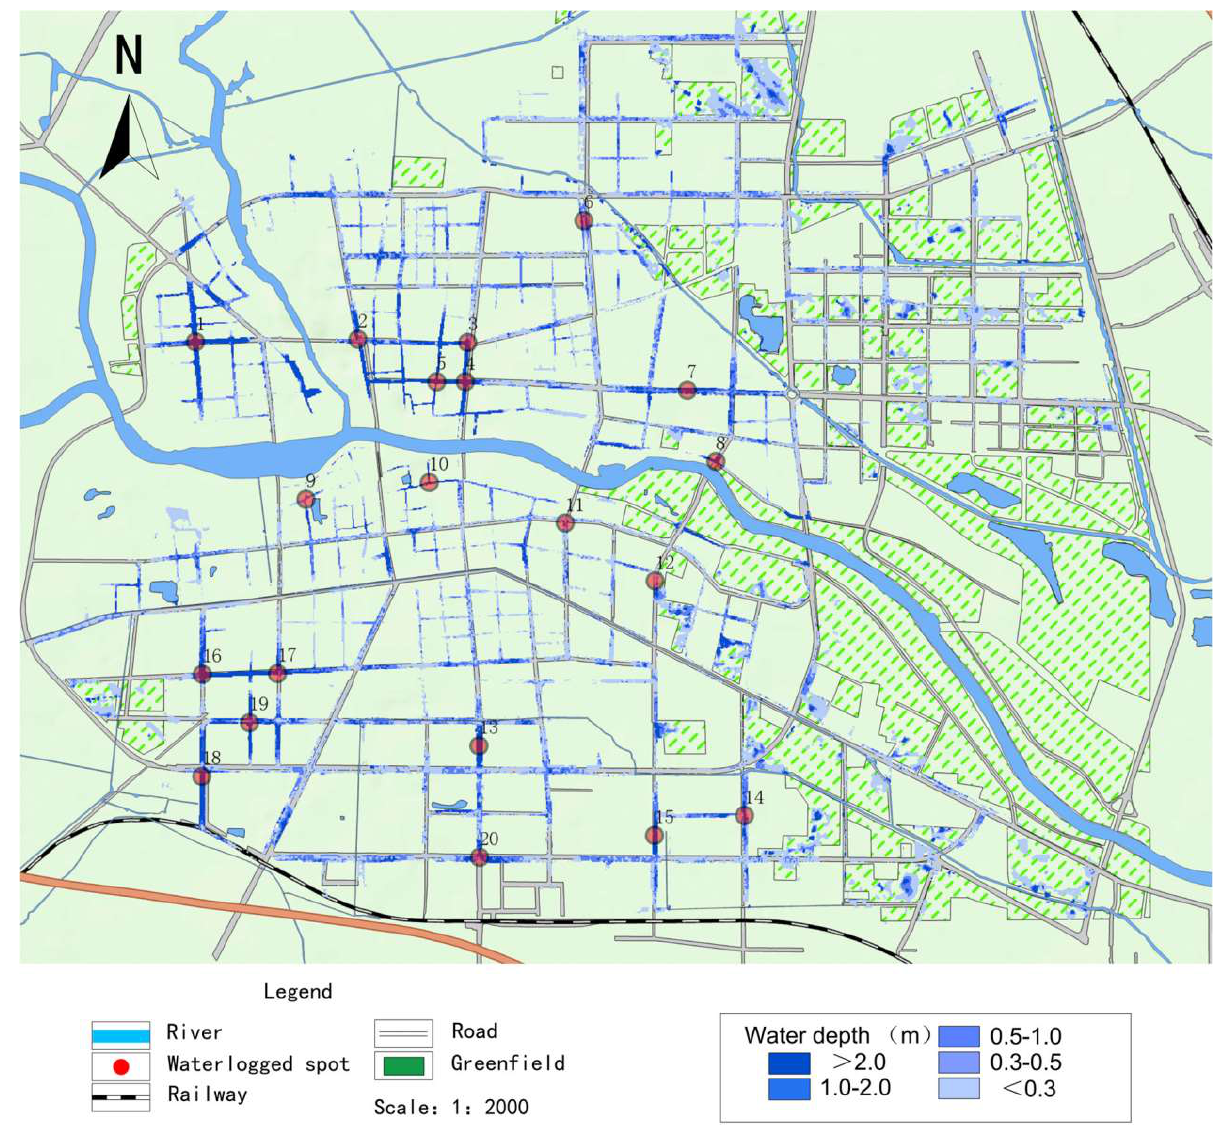
Figure 6. Distribution of major waterlogged site on 20 July 2021. Table 2. Comparison of measured and numerically modeled ponding depths at inundated water points on 20 July 2021.